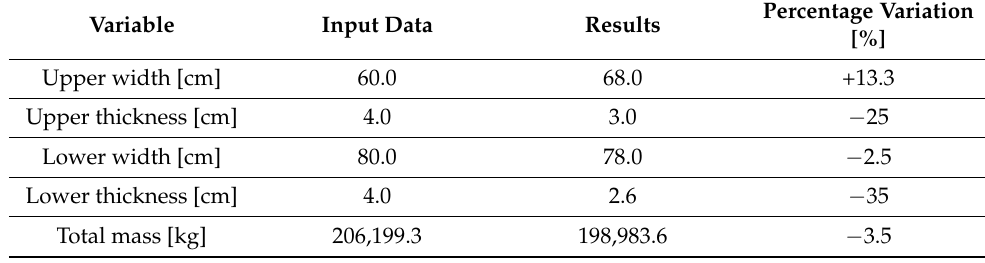
Table 7. Design variables and objectives before and after the optimization process.